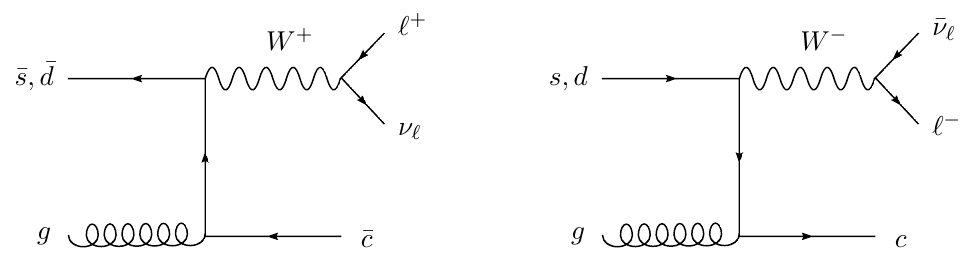
Figure 1 . Feynman diagrams describing W + c production at LO